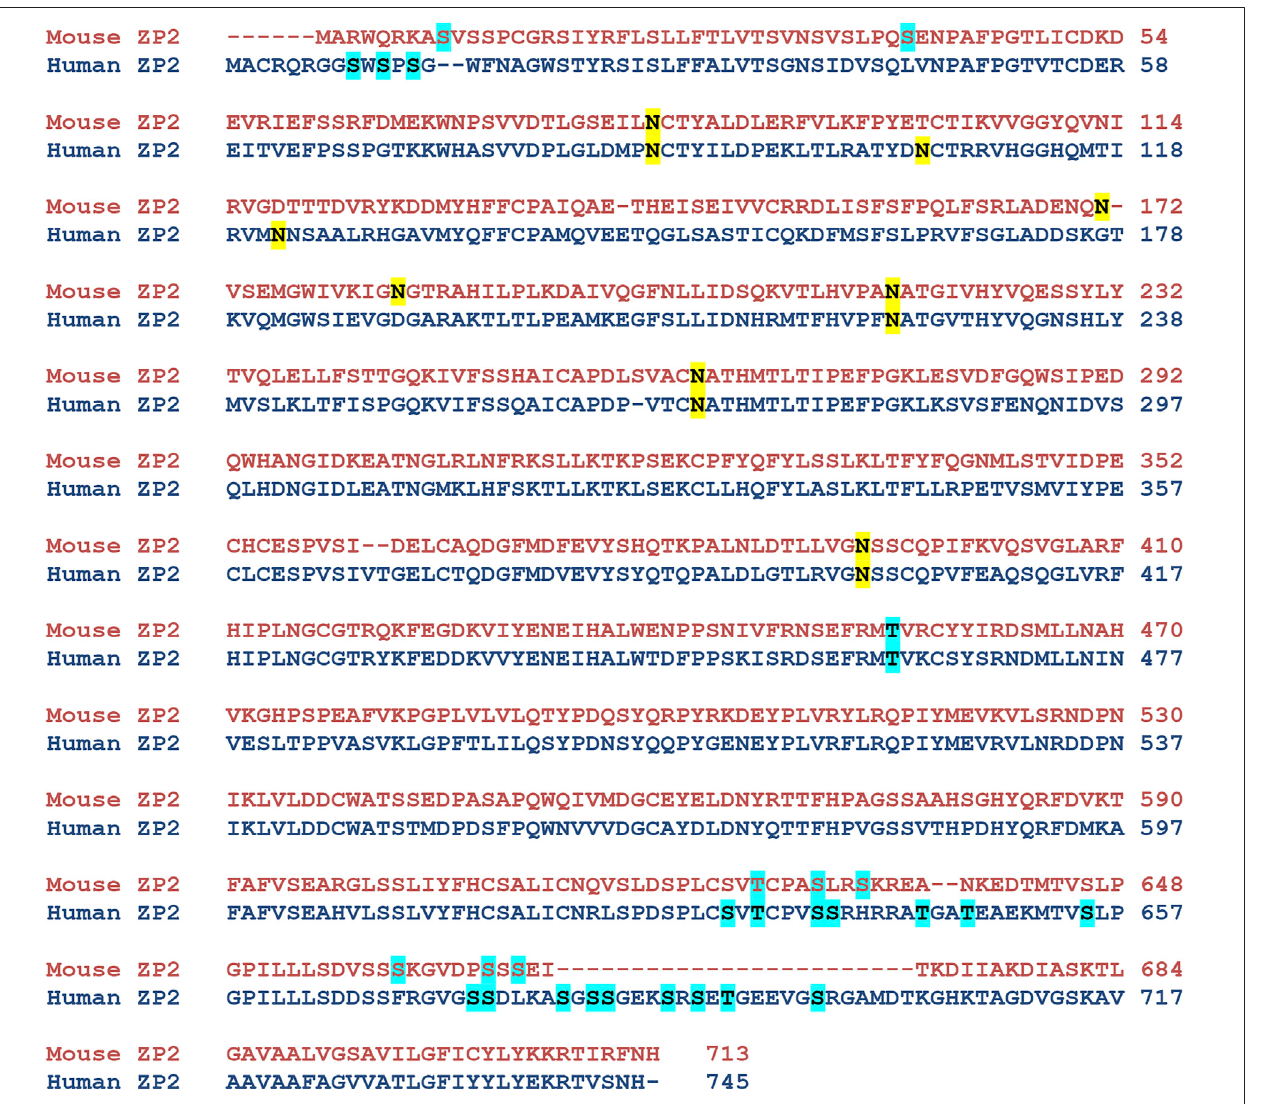
Frontiers in Cell and Developmental Biology |